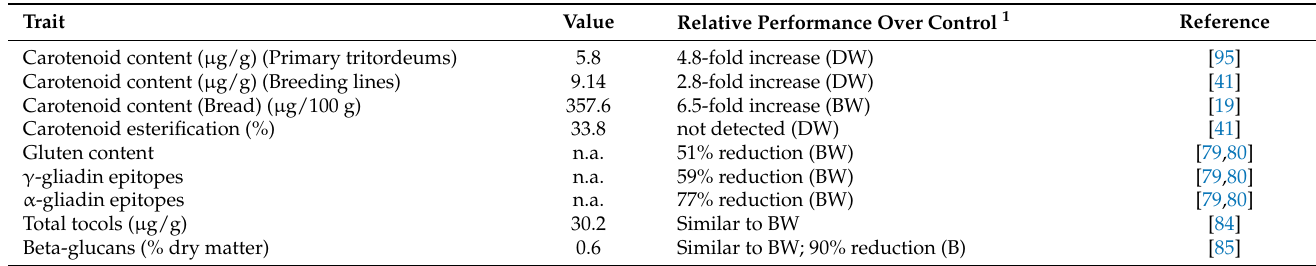
Table 3 summarizes the main quality attributes of tritordeum grain. Table 3. Grain quality parameters in